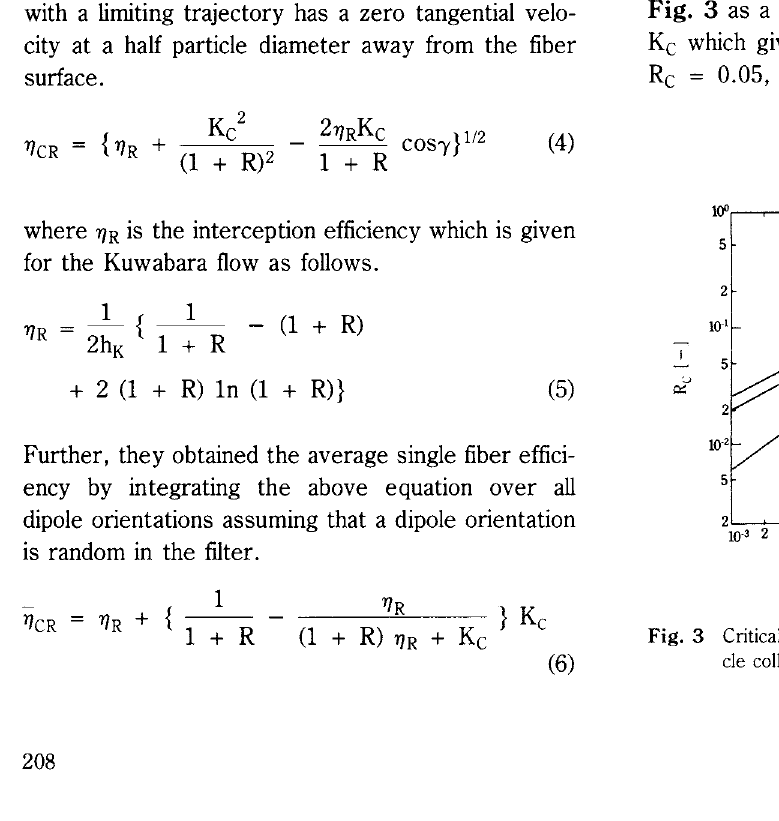
Fig. 3 Critical interception parameter for Coulombic force parti cle